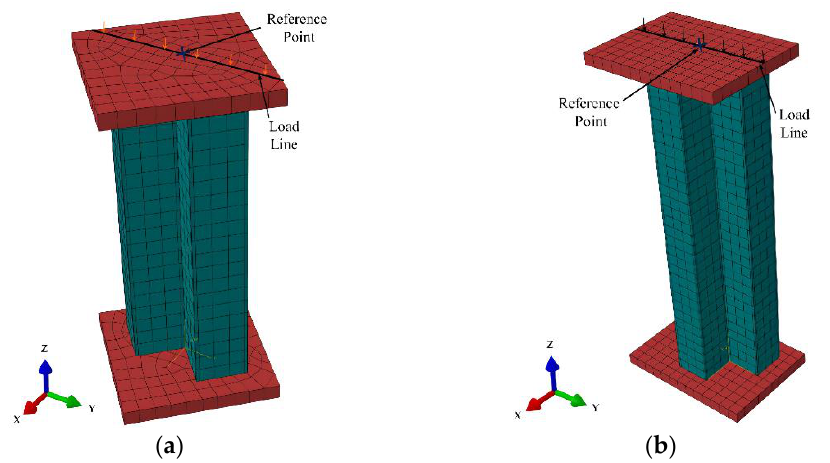
Figure 18. Boundary Conditions ( a ) L-shaped; ( b ) T-shaped.